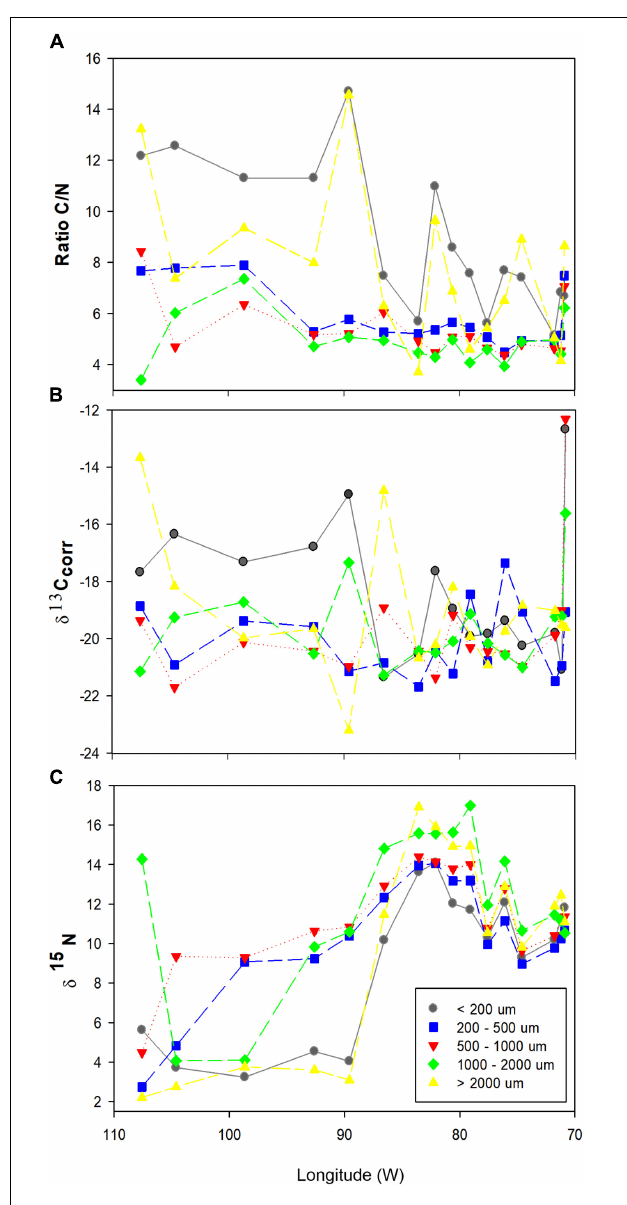
FIGURE 3 | Biochemical variables of size-fractioned zooplankton across the zonal gradient: (A) C:N ratio, (B) stable carbon isotopes ( δ 13 C), (C) stable nitrogen isotopes ( δ 15